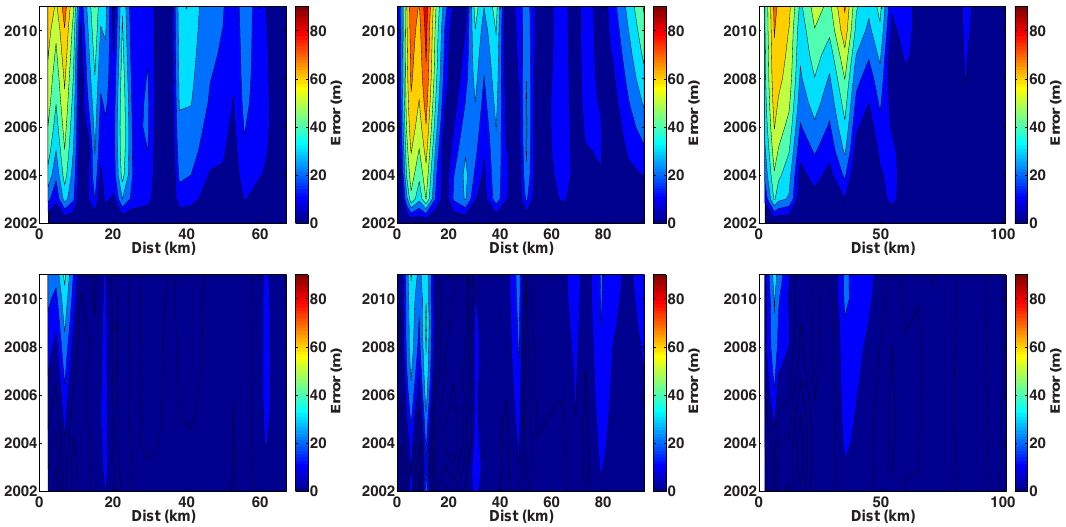
Figure 3. Comparison of transient misfit of modeled surface elevation between snapshot and transient calibration along different flow lines. From left to right, panels correspond to flow lines in Fig. 1c in descending order. Top row panels: snapshot calibration. Bottom row panels: transient calibration.